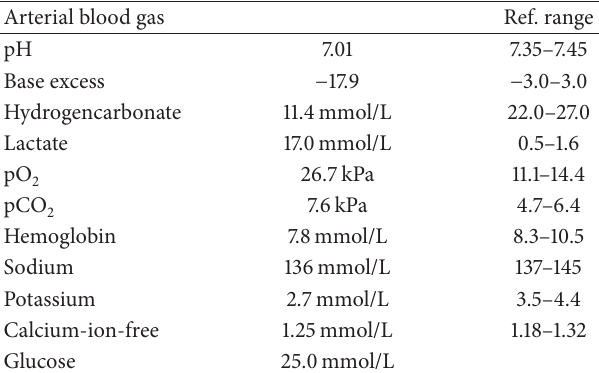
Table 1: Arterial blood